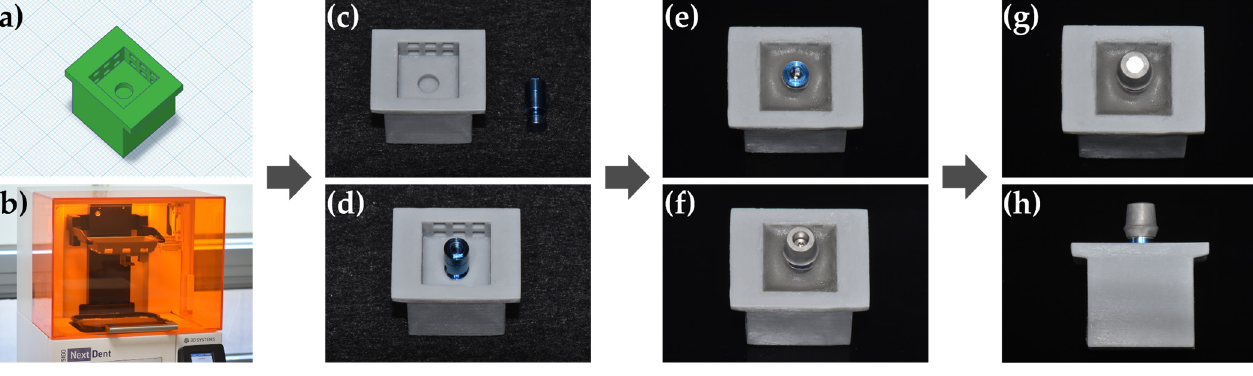
Figure 2. A process of lab analog embedding and titanium abutment fixation. ( a ) CAD data of the jig. ( b ) 3D printing process. ( c ) 3D-printed jig and lab analog. ( d ) Lab analog in the jig hole. ( e ) Lab analog embedded in acrylic resin. ( f ) Titanium abutment fixed to a lab analog with 35 Ncm torque. ( g ) Filling screw hole using Teflon tape. ( h ) Complete lab analog-titanium abutment